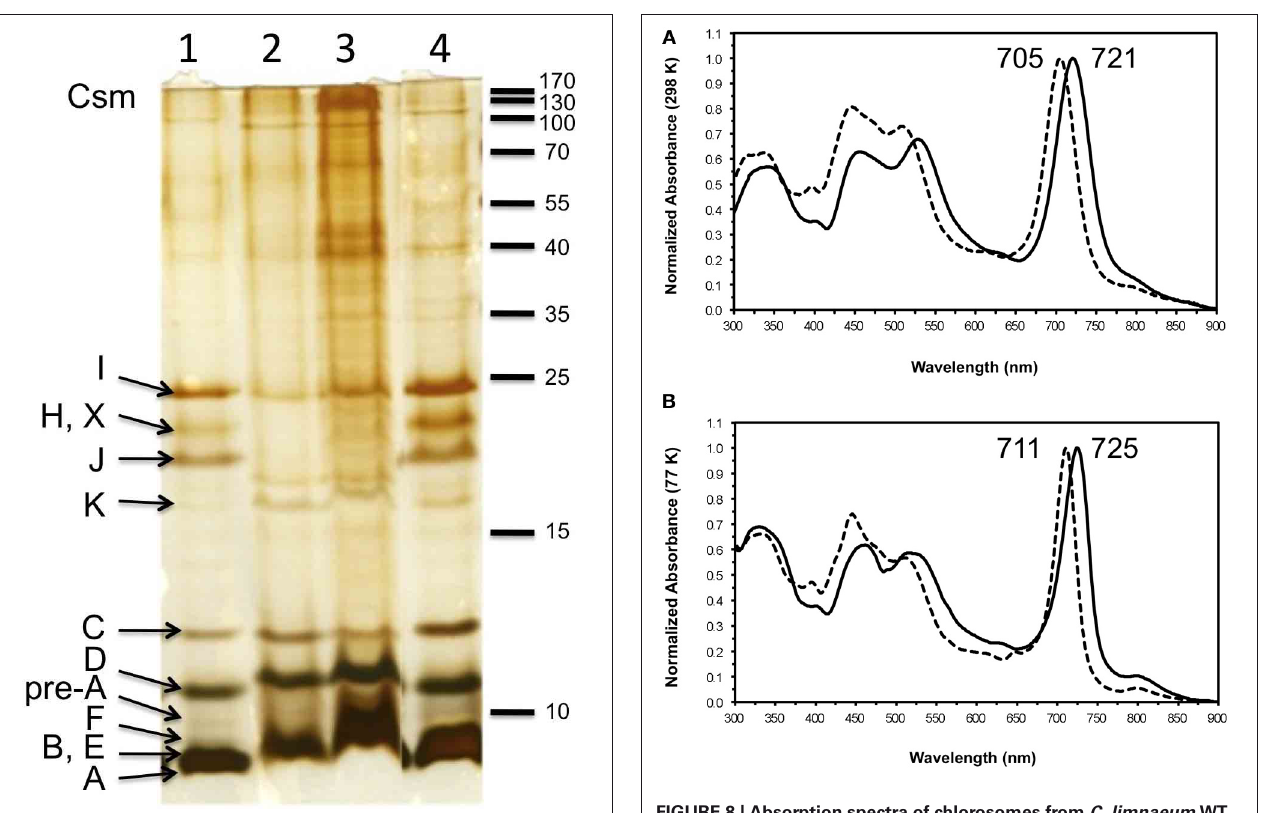
FIGURE 7 | SDS-PAGE analysis of polypeptide composition of chlorosomes from C. tepidum (lanes 1 and 4), C. limnaeum bchU mutant (lane 2), and C. limnaeum WT (lane 3). The sizes of marker polypeptides are shown at the right in kDa. The identities of chlorosome proteins in C. tepidum chlorosomes are indicated at the left. Proteins corresponding to ∼ 20 μ g of BChl were loaded on each lane.